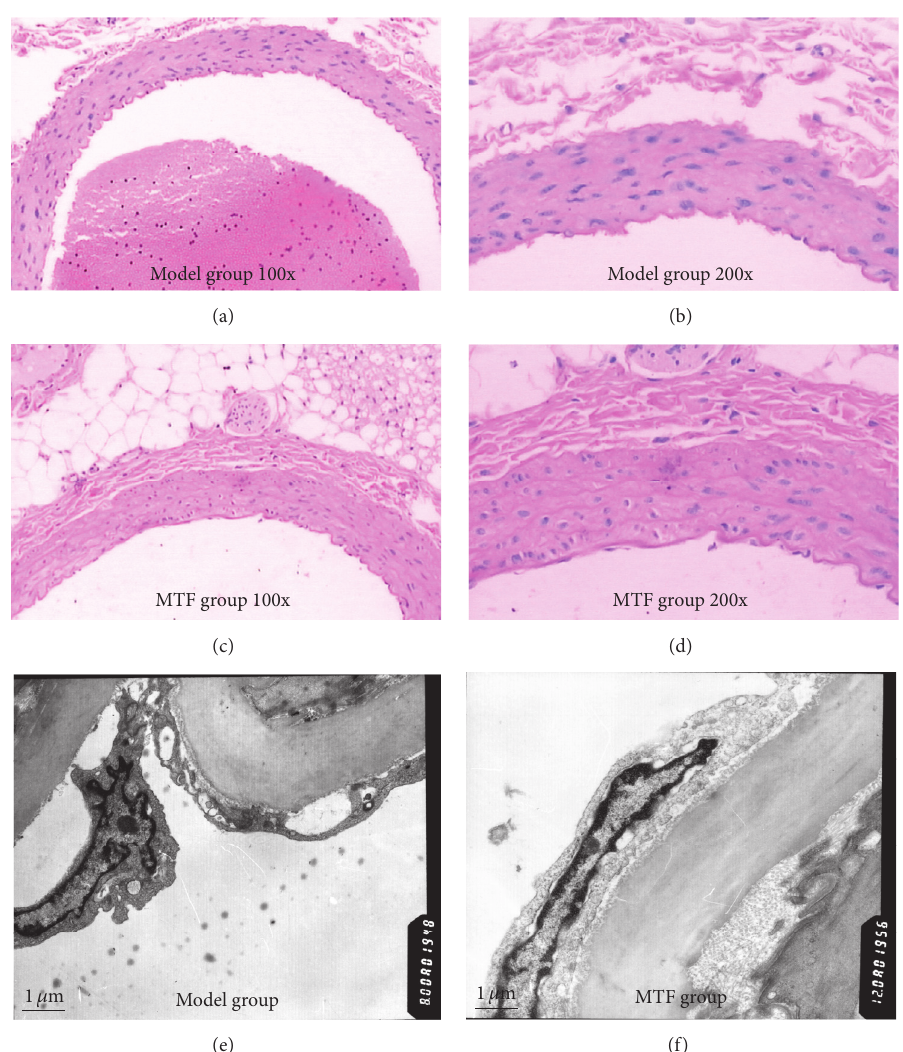
Figure 2: Histomorphological and ultrastructural observations of the femoral artery. (a) Histomorphological observation of model group (magnification × 100); (b) histomorphological observation of model group (magnification × 200); (c) histomorphological observation of MTF group(magnification × 100);(d)histomorphologicalobservationofMTFgroup(magnification × 200);(e)ultrastructuralobservationofmodel group; (f) ultrastructural observation of MTF